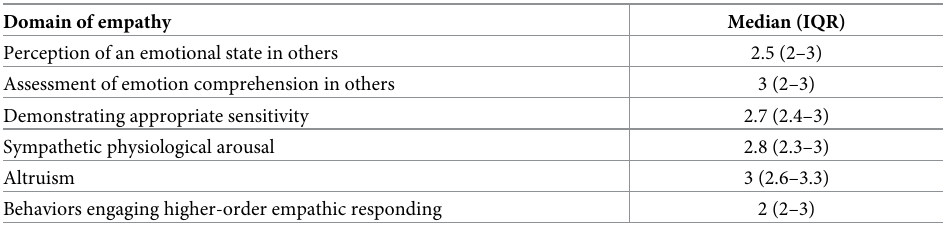
Table 2. Subgroups of empathy according to the Toronto Empathy